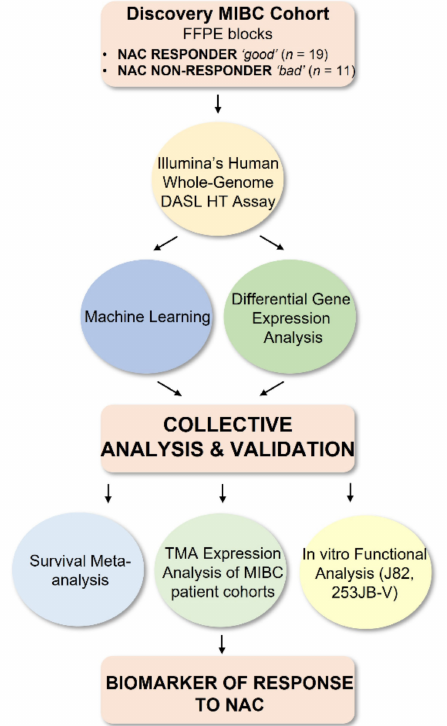
Figure 1. Overview of the study. This study represents a multi-methods analysis approach of machine learning and differential gene expression analysis following performance of gene expression profiling on a cohort of MIBC patients highly selected for an exquisitely strong response to NAC (responder) or marked resistance and/or progression (non-responder). Identified gene signatures and top ranked gene markers were subjected to validation using meta-analysis, immunohistochemistry and in vitro functional assays. FFPE, formalin-fixed paraffin-embedded; TMA, tissue microarray analysis; MIBC, muscle-invasive bladder cancer; NAC, neoadjuvant